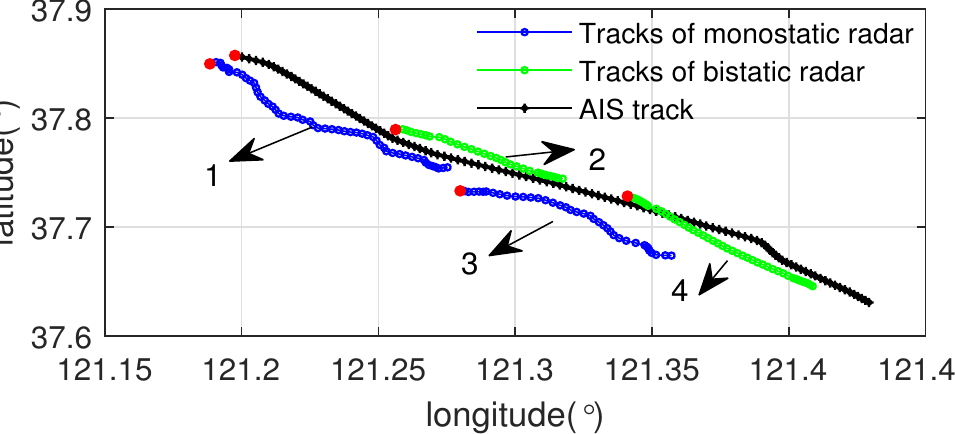
Figure 5. Comparison between radar tracks and automatic identification system (AIS) track of target